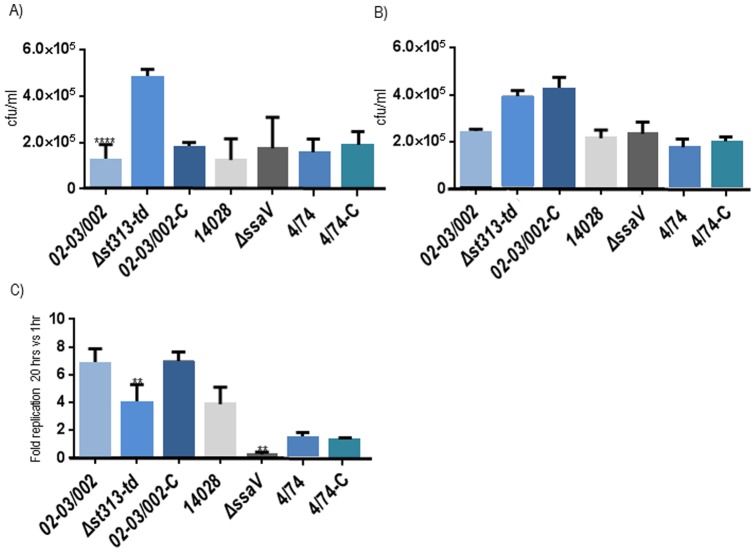
Infection of J774 mouse macrophages.Intracellular survival/replication, A) at t = 1 h post-infection with opsonisation, B) at t = 1 h post-infection without opsonisation, and C) at t = 20 h post-infection with opsonisation, and with regards to t = 1 h post-uptake (the intracellular survival at t = 1 h for all the tested isolates is regarded as 1.0). Strains tested were: S. Typhimurium WT 02–03/002, 4/74 and 14028 and the mutant isolates: Δst313-td, 02-03/002-C (pAHF4, complemented strain), 4/74-C (pAHF4) and ΔssaV. The experiments were repeated at least 4 times with similar results and shown is an average of these. Errorbars indicate standard deviation. Statistical significance (****  = P<0,00001; **  = P<0,001) was determined by one-way ANOVA analysis with pair-wise comparison of means.